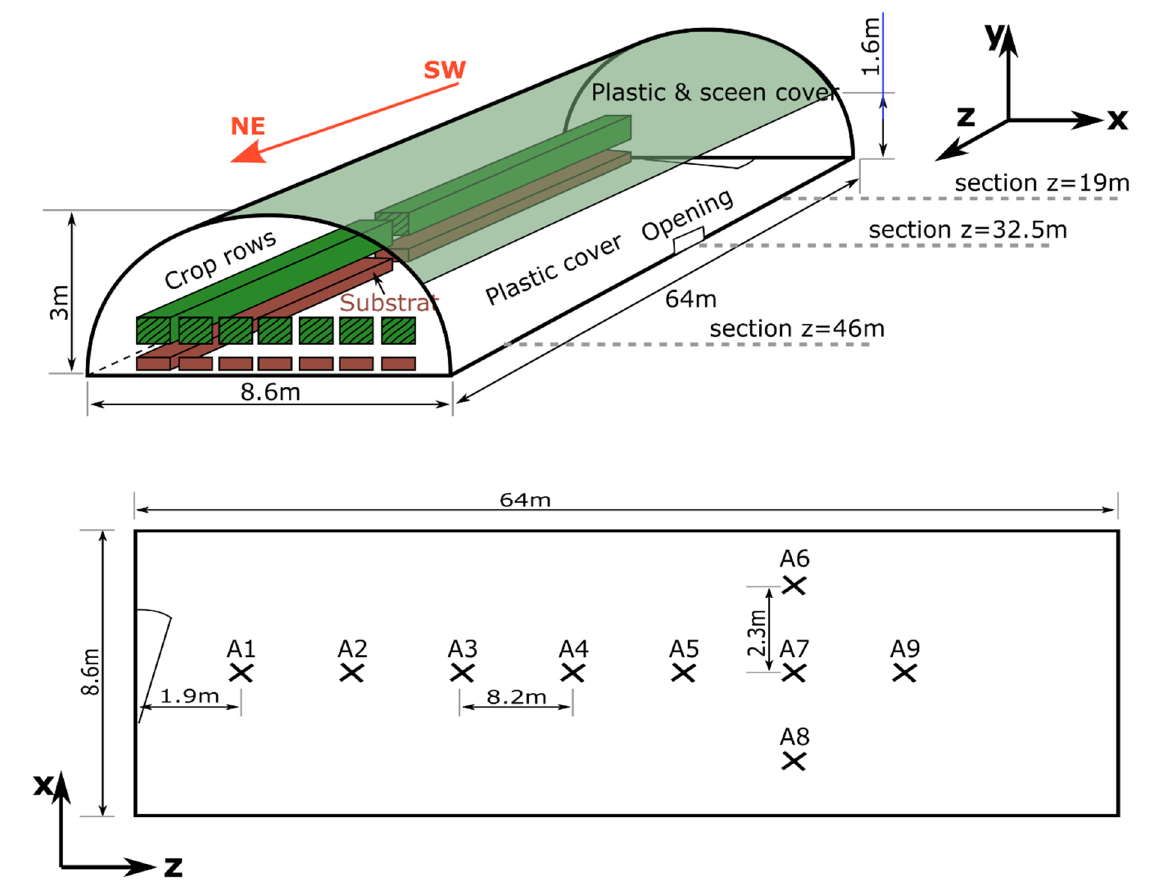
Figure 1. Schematic view of the studied greenhouse and sensor’s